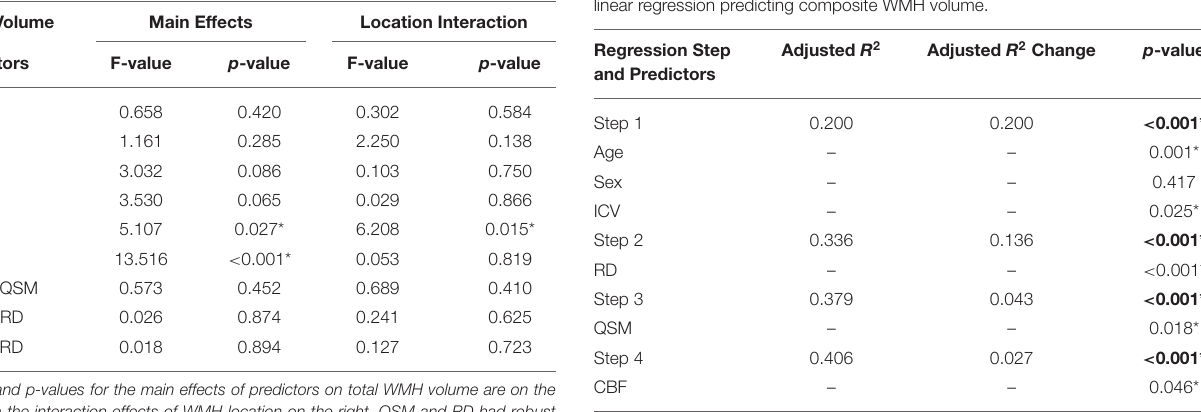
TABLE 2 | Summary of main effects and interactions of predictors on WMH volume and location.